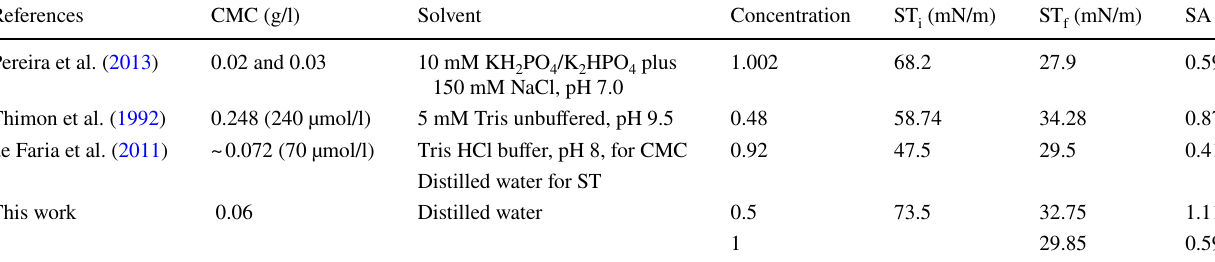
Table 1 Surface activity (SA) of the surfactin produced by MJ01 strain in comparison with the literature